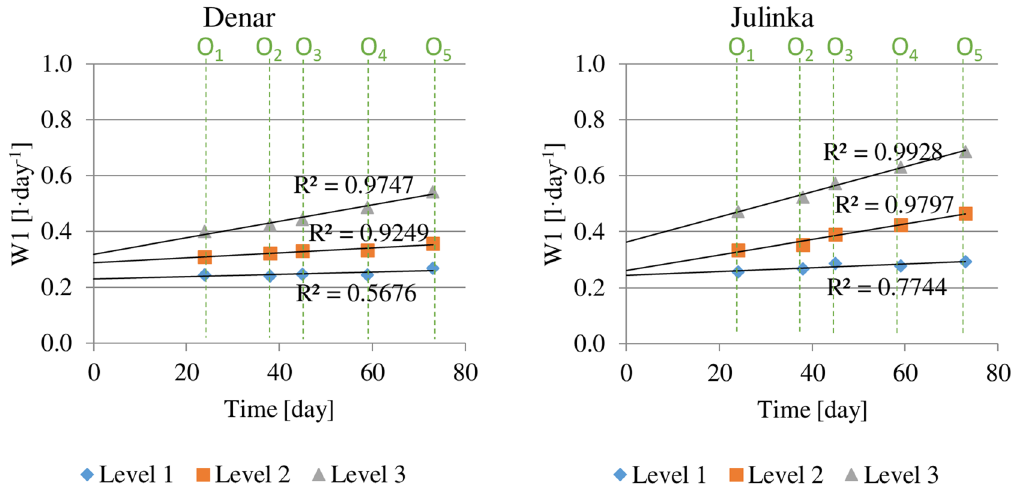
Figure 5. Average daily water consumption for potato varieties, at three soil humidity levels (1, 2, 3), cumulative calculation from potato